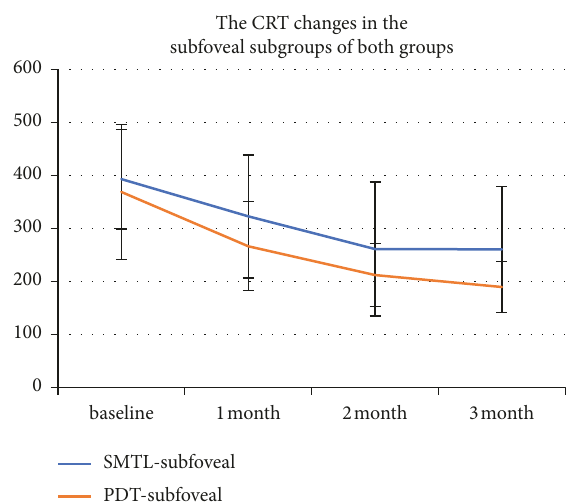
Figure 5: Central retinal thickness (CRT) changes in the parafoveal subgroup in the SMTL and half-dose PDT groups. The CRT at the baseline and 1, 2, and 3 months during the follow-up period is shown in the figure. The change in CRT in the PDT-parafoveal group was defined with a red line chart, while the change in CRTin the SMTL-parafoveal group was defined with a blue line chart. There was a significant difference at 1 m between the two subgroups after treatment ( P 0 . 024). (cid:31)